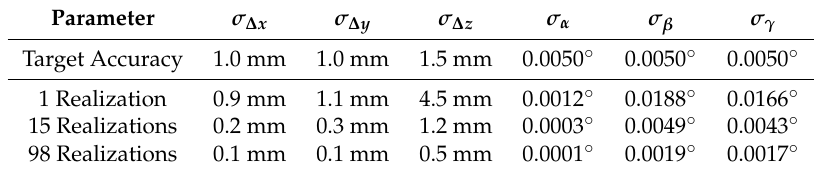
Table 3. Standard deviations for a single calibration run and multiple calibration